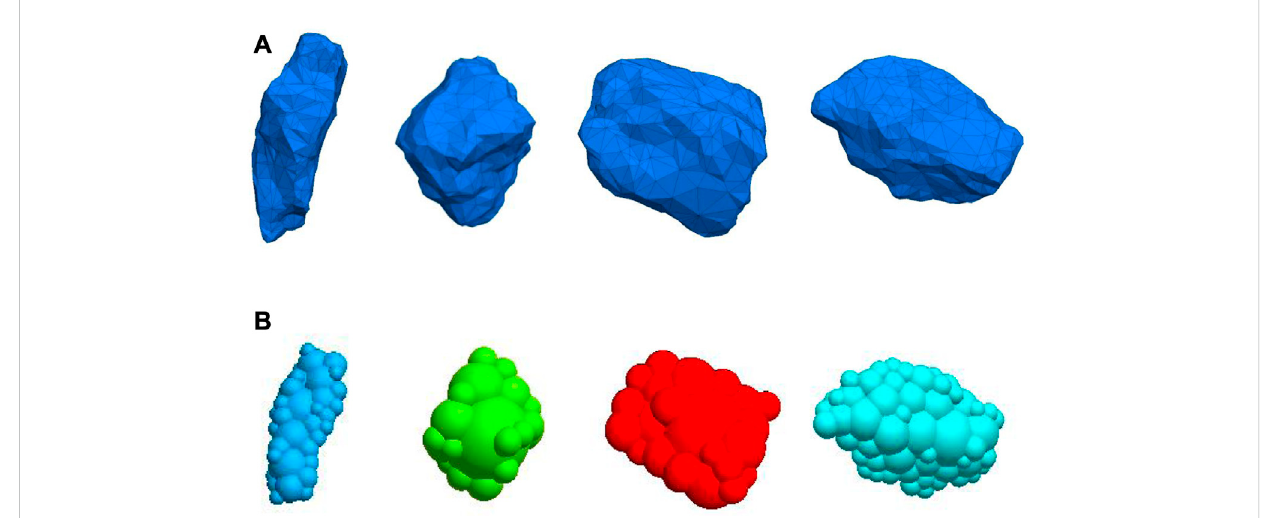
FIGURE 6 Product aggregates of different shapes: (A) real aggregate model; (B) aggregate cluster template.